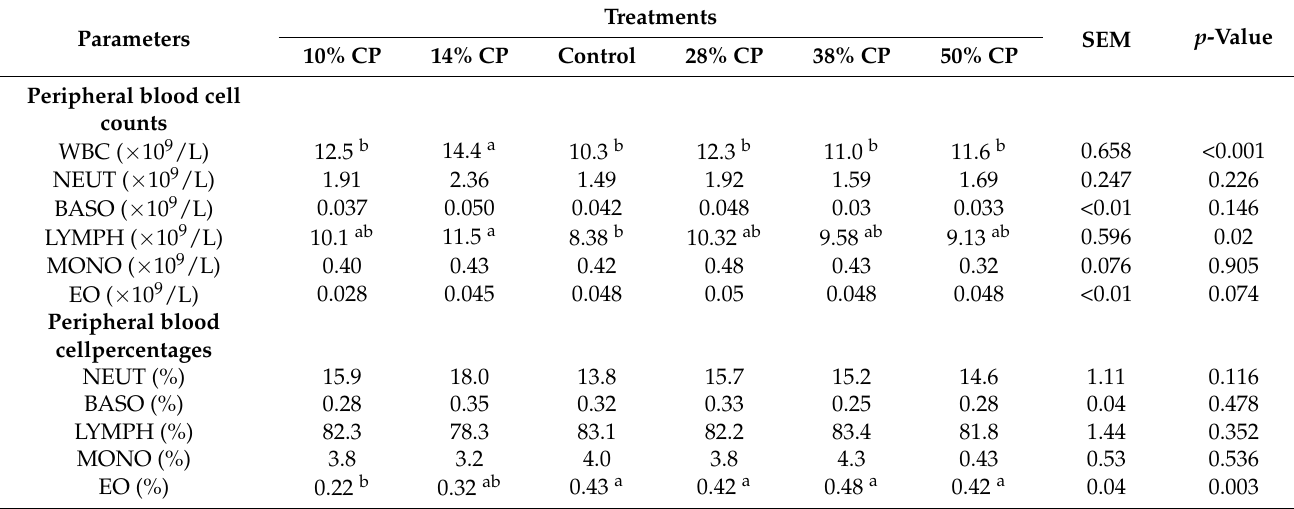
Table 4. Effects of dietary protein contents on the peripheral blood cell counts of SD